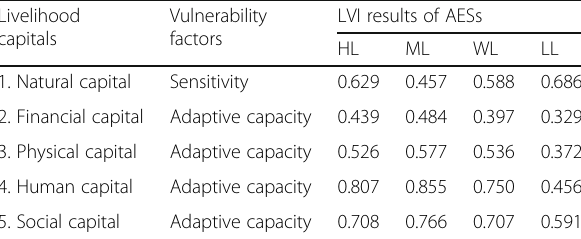
Table 5 Livelihood capitals and relative vulnerability of agro- ecological systems Livelihood